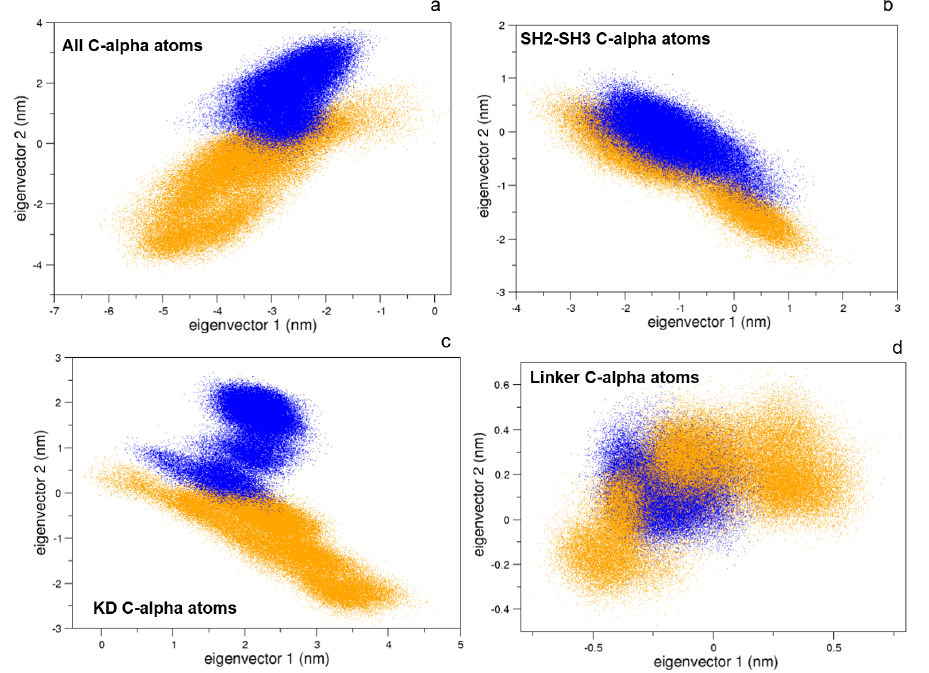
Figure 11. Projections of the MD sampled structures on the essential eigenvectors of the combined trajectories of c-Src (blue) and c-Src:imatinib (orange). Alpha carbons were used. ( a ) Whole protein, ( b ) SH2-SH3 domains, ( c ) kinase domain, and ( d )